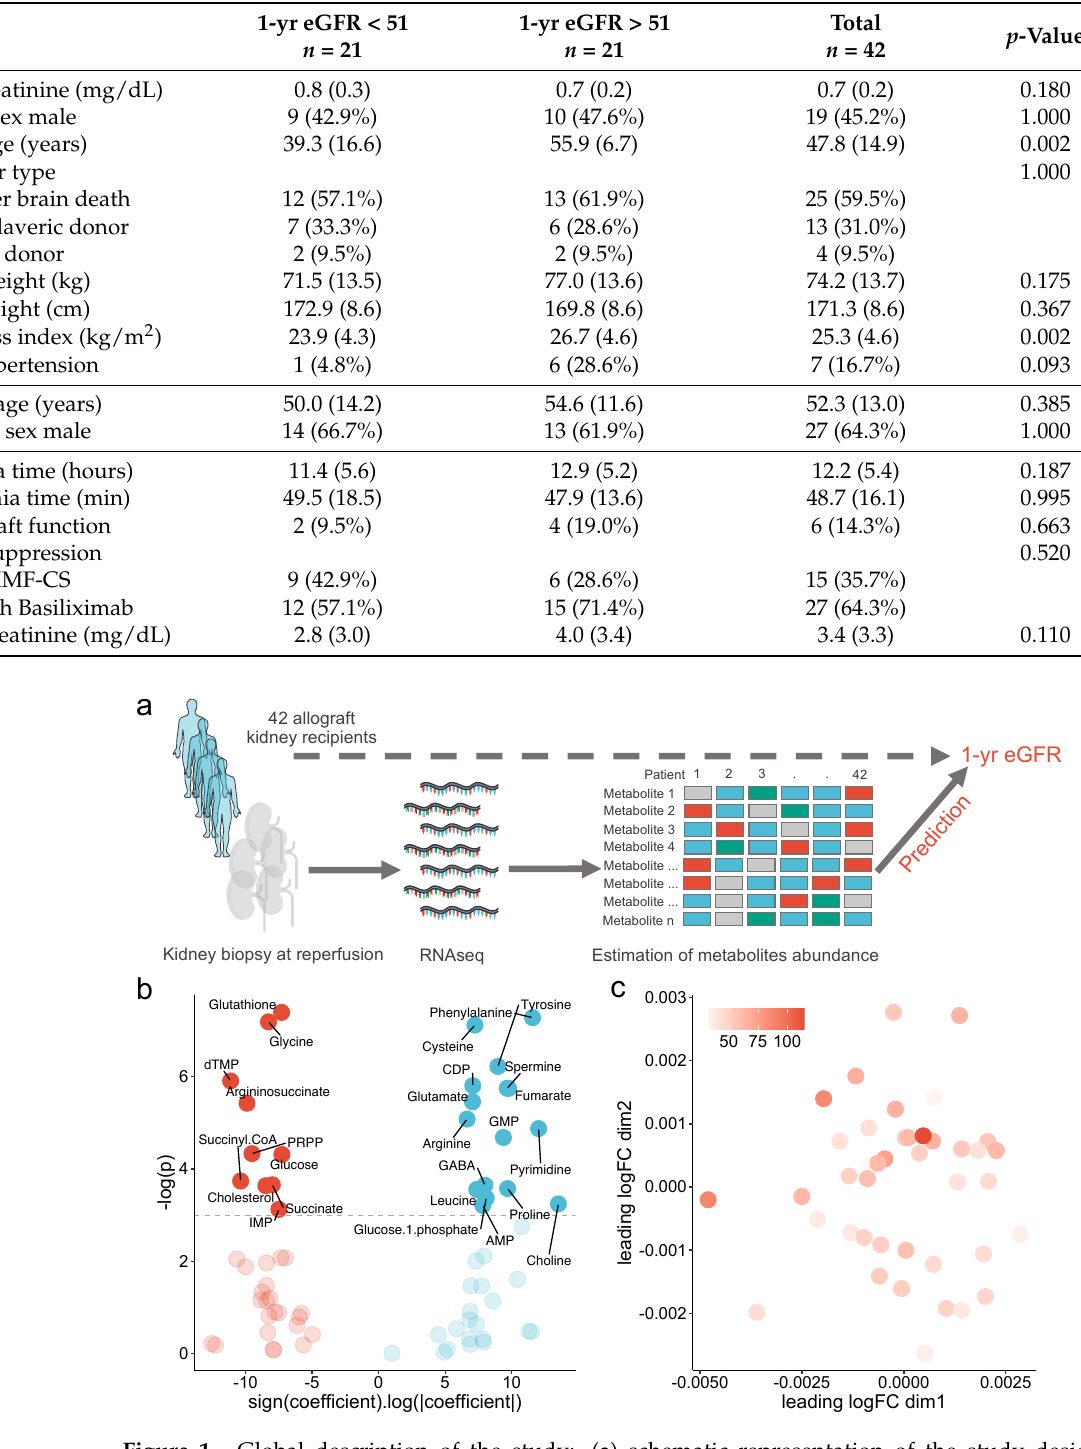
Figure 1. Global description of the study: ( a ) schematic representation of the study design, ( b ) volcano-plot showing the signed logarithm of the absolute ß coefficient extracting from a ro- bust linear model using one-year eGFR as the dependent variable, and its associated p -value, for each estimated metabolite abundance, and ( c ) scatter plot showing the multidimensional scaling of the estimated metabolomics, colored by the one-year